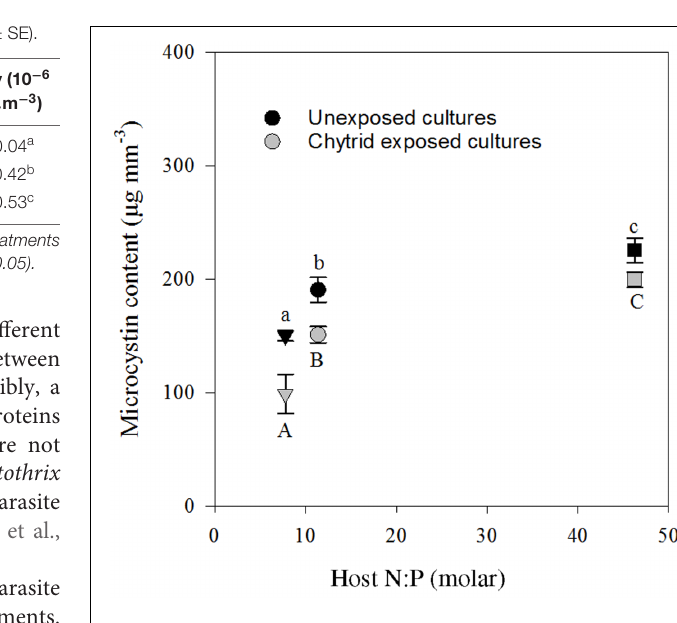
FIGURE 5 | Seston microcystin content in the cultures with and without parasite exposure, in the control (circle), low N:P (triangle) and high N:P (square) treatments. Symbols represent mean ± standard error ( n = 4). Letters denote significant differences between treatments of unexposed (lower case) and chytrid exposed (upper case) cultures based on One-way ANOVA and post hoc comparison of the means ( α <